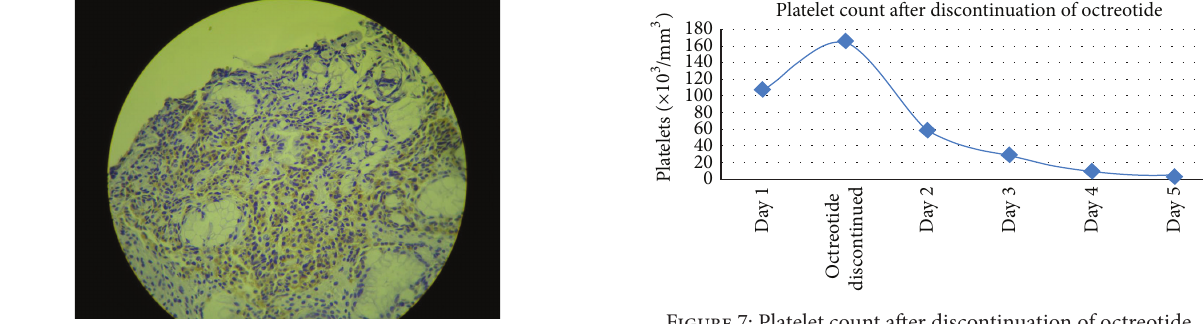
Figure 4: Immunohistochemistry exam positive for synaptophysin.